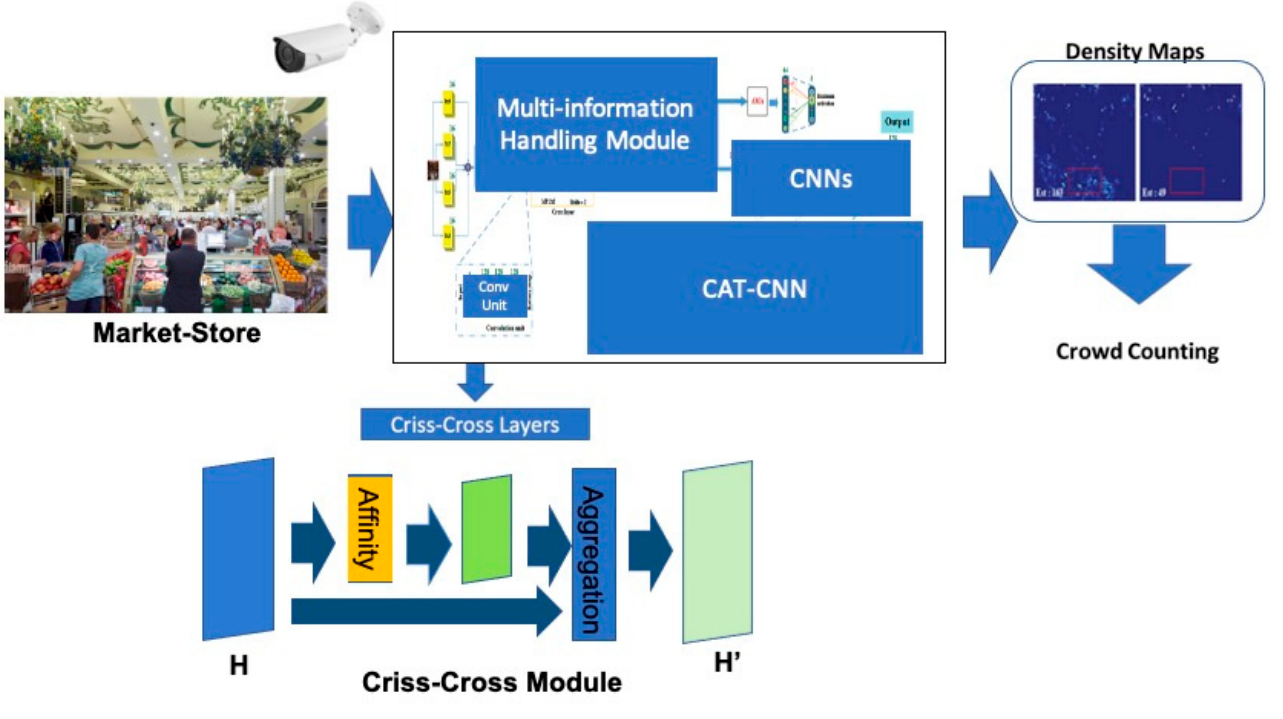
Figure 2. The proposed Visual Counting